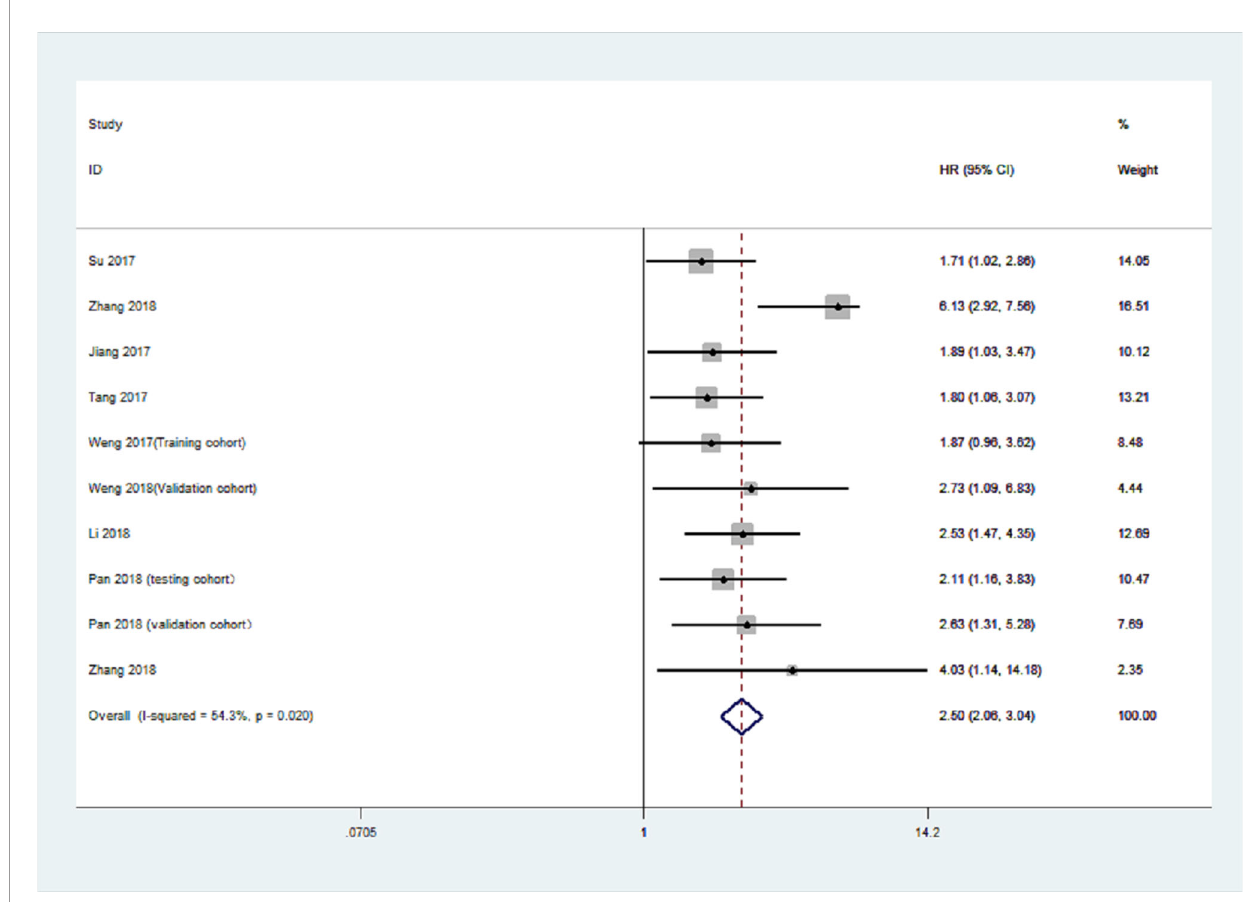
FIGURE 2 | Forest plot of the hazard ratio (HR) for CDR1as increase and overall